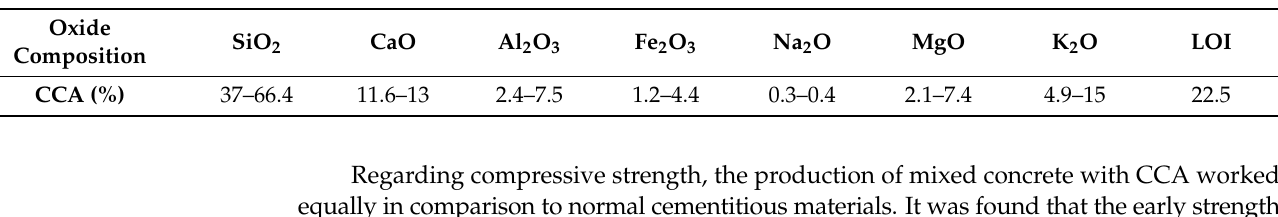
Table 8. Oxide composition of CCA